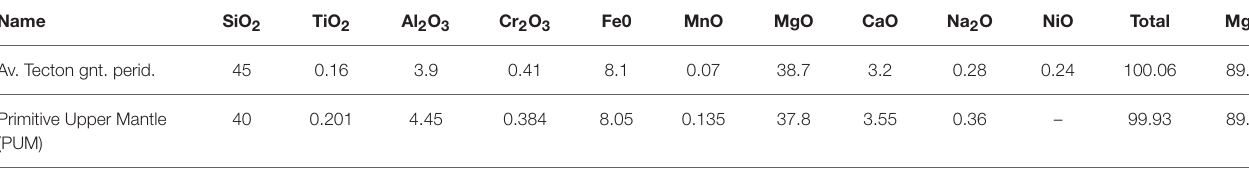
TABLE 1 | Bulk mantle compositions used in this work from xenolith suites and peridotite massifs. Name